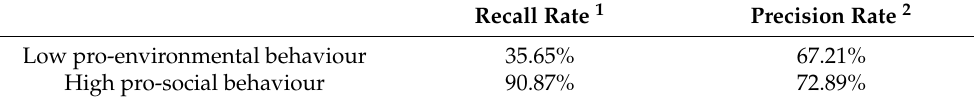
Table 7. Recall and precision of the prediction